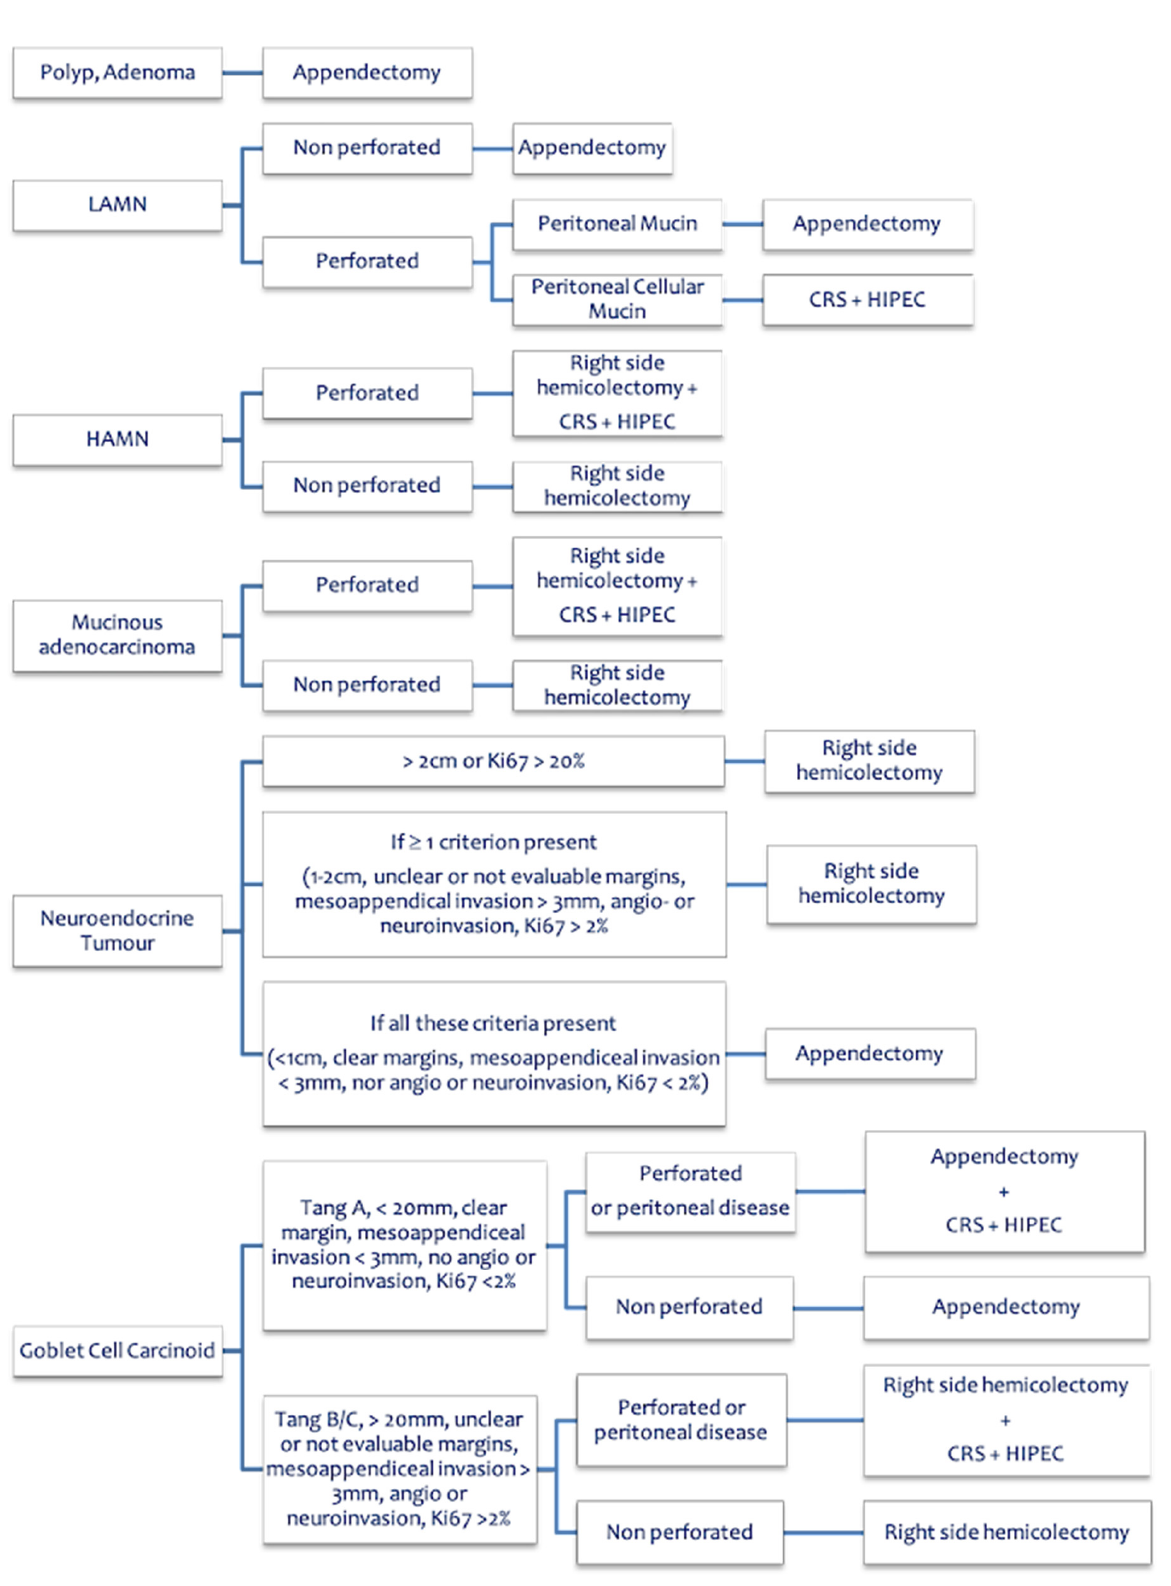
Figure 2. Primary appendiceal cancer treatment. LAMN = Low-grade Appendiceal Mucinous Neoplasm; HAMN = High grade Appendiceal Mucinous Neoplasm; CRS = Cytoreductive Surgery; HIPEC = Hyperthermic IntraPEritoneal Chemotherapy.